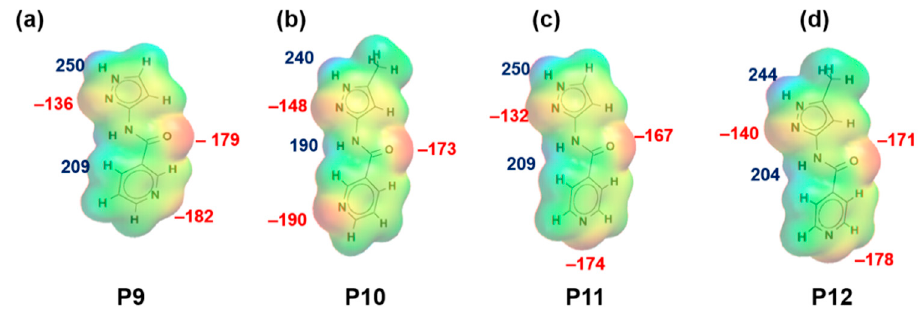
Figure 2. Electrostatic potential values (in kJ/mol); ( a ) P9, ( b ) P10, ( c ) P11 and ( d ) P12 . Red indicates MEPs on hydrogen-bond acceptors and blue indicates MEPs on hydrogen-bond donors. Table 1. Hydrogen-bond energies (in kJ/mol) for each combination synthon for molecules P1 – P12 . Green shade indicates the most likely predicted synthons by this